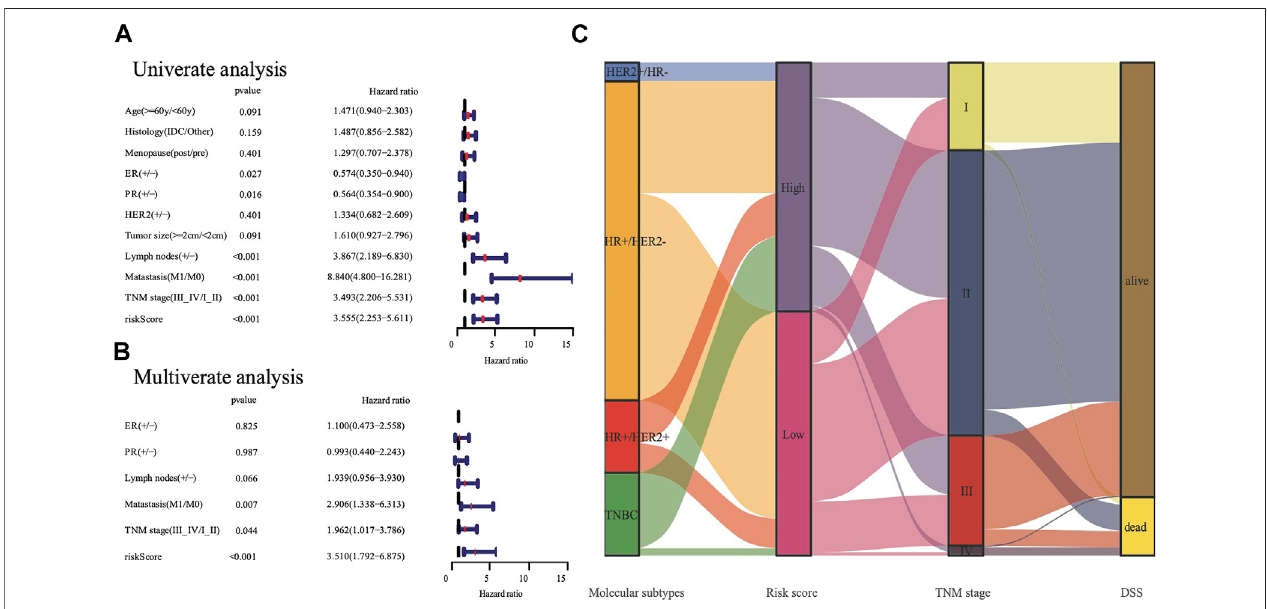
FIGURE 4 | The analysis nine gene panel of FRG based on TCGA. The hazard ratio of univariate and multivariate Cox regression analysis (A,B) , (+/ -) means (positive/negative). A Sankey map demonstrated the relationship between FRG risk score and molecular subtypes (C) .